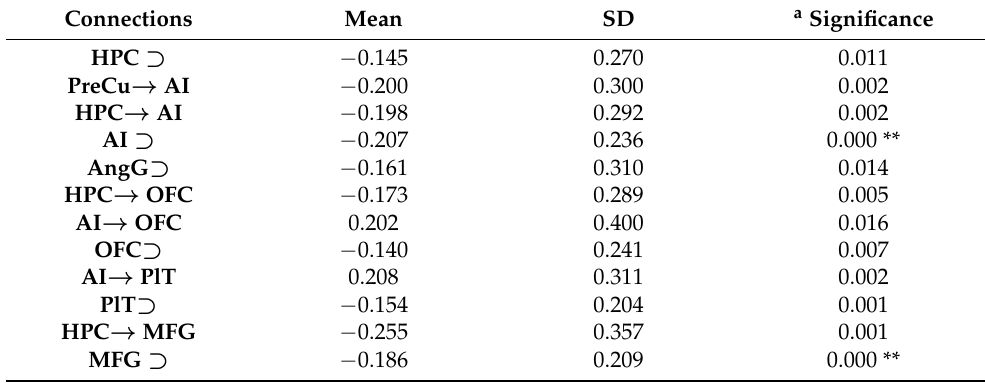
Table 5. Connections significantly different from zero in the depressed